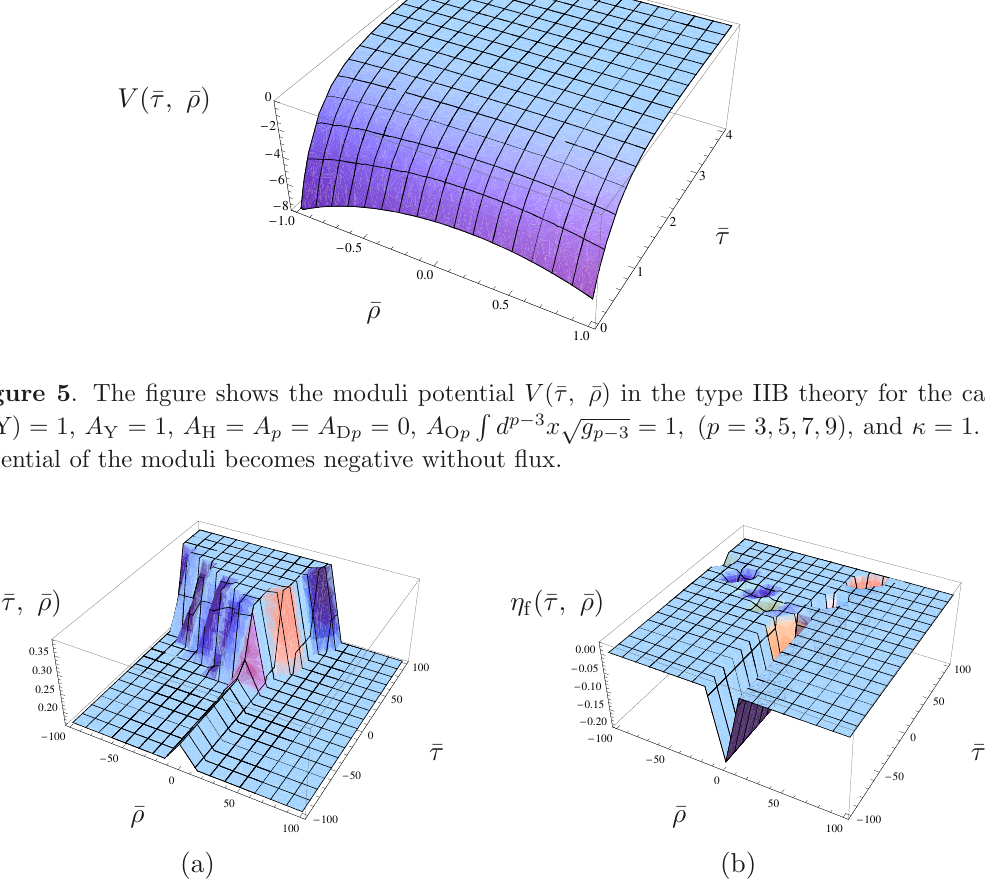
Figure 6 . We shows the behavior of parameters ε f (¯ τ, ¯ ρ ), η f (¯ τ, ¯ ρ ) for the type IIB theory. We set R (Y) = 1, A Y = 1, A H = A p = A D p = 0, A O